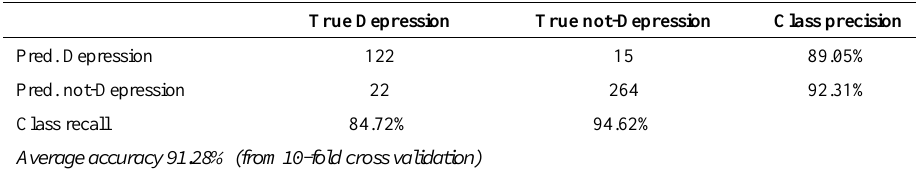
Table 8. The accuracy, precision, and recall of suicide prediction model using six important trauma items and four important suicide items with random forest